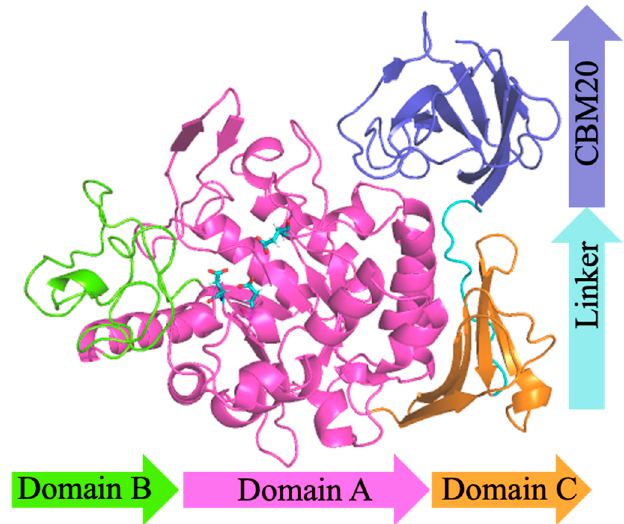
Figure 1. Overall structural model of MFA ps . Domains A, B, C, linker and CBM20 are rendered in blue, pink, green, cyan and blue, respectively. Catalytic residues and Ca 2 + are represented by cyan sticks and green spheres, respectively.